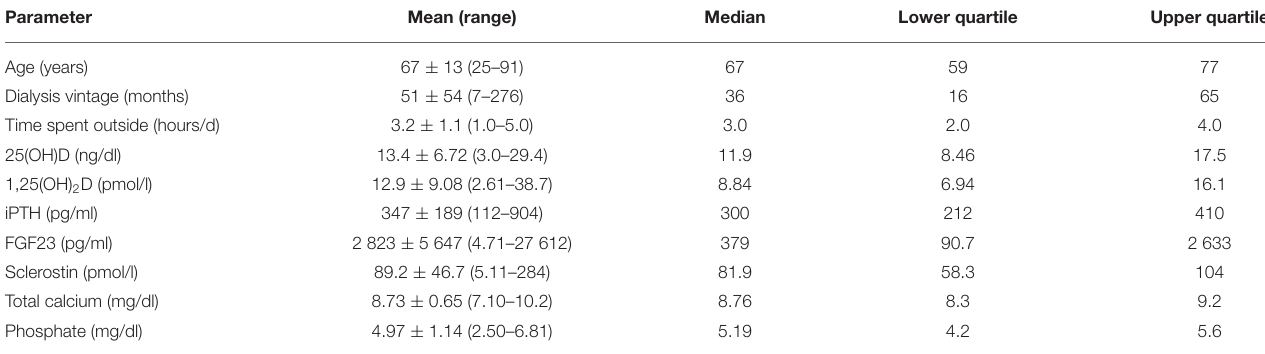
TABLE 1 | The clinical and biochemical parameters of the 81 patients who finally took part in the